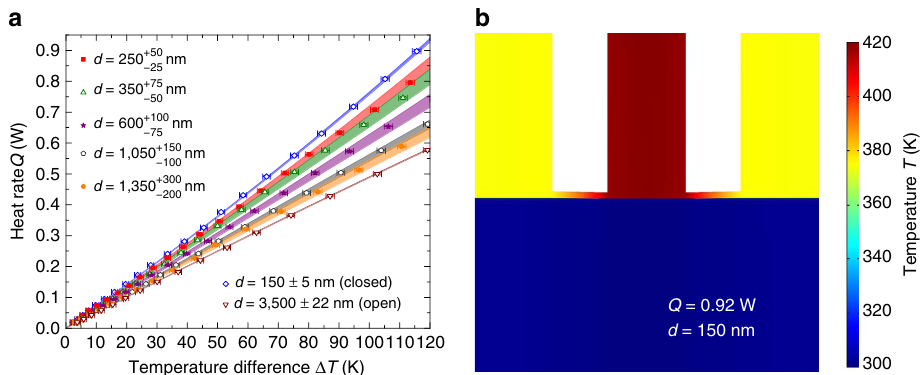
Figure 2 | Gap- and temperature-dependent heat rate. ( a ) Heat rate, Q , as a function of the temperature difference between the emitter and receiver, D T , for various separation gaps, d . In all cases, the temperature of the receiver, T r , is fixed at 300K. The symbols show unprocessed experimental data, while the coloured bands are numerical simulations obtained from the coupled fluctuational electrodynamics-COMSOL Multiphysics comprehensive model. The gap sizes d in the open and closed positions are known, with some small uncertainty, from the manufacturing of the device and the associated measured heat rates are in good agreement with numerical predictions. It was not possible to measure directly the intermediate gap sizes, such that they were estimated from the comprehensive heat transfer model. ( b ) Simulated temperature distribution in the device via the comprehensive model for an input heat rate Q of 0.92W, a separation gap d of 150nm and a fixed receiver temperature T r of 300K resulting in an emitter temperature of 420K. Heat spreading outside the emitter portion of the device results in background heat transfer Q back